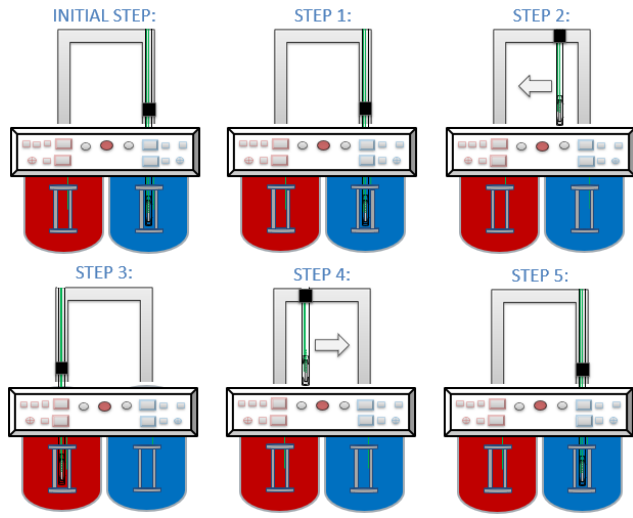
Fig. 6 Diagram of the thermal transient